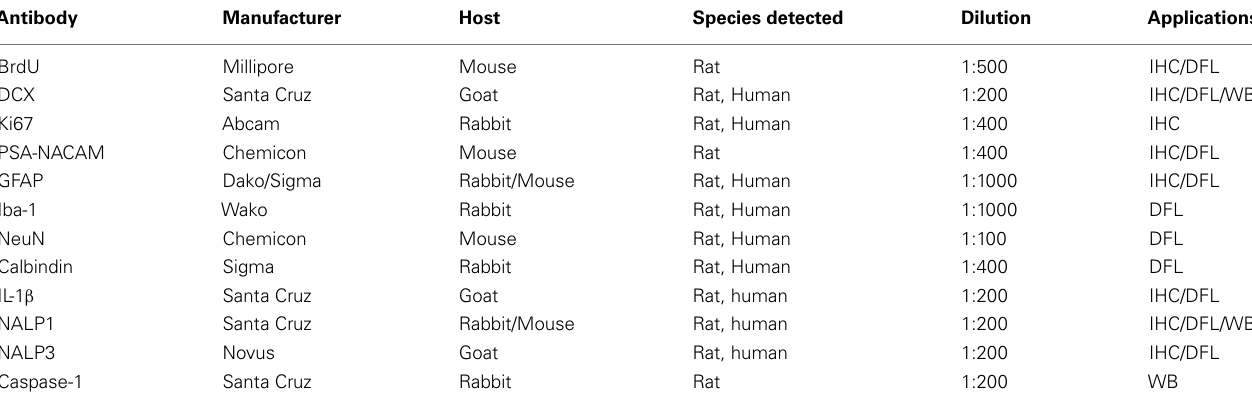
Table 1 | Summary of antibodies used in the present study. Antibody Species detected